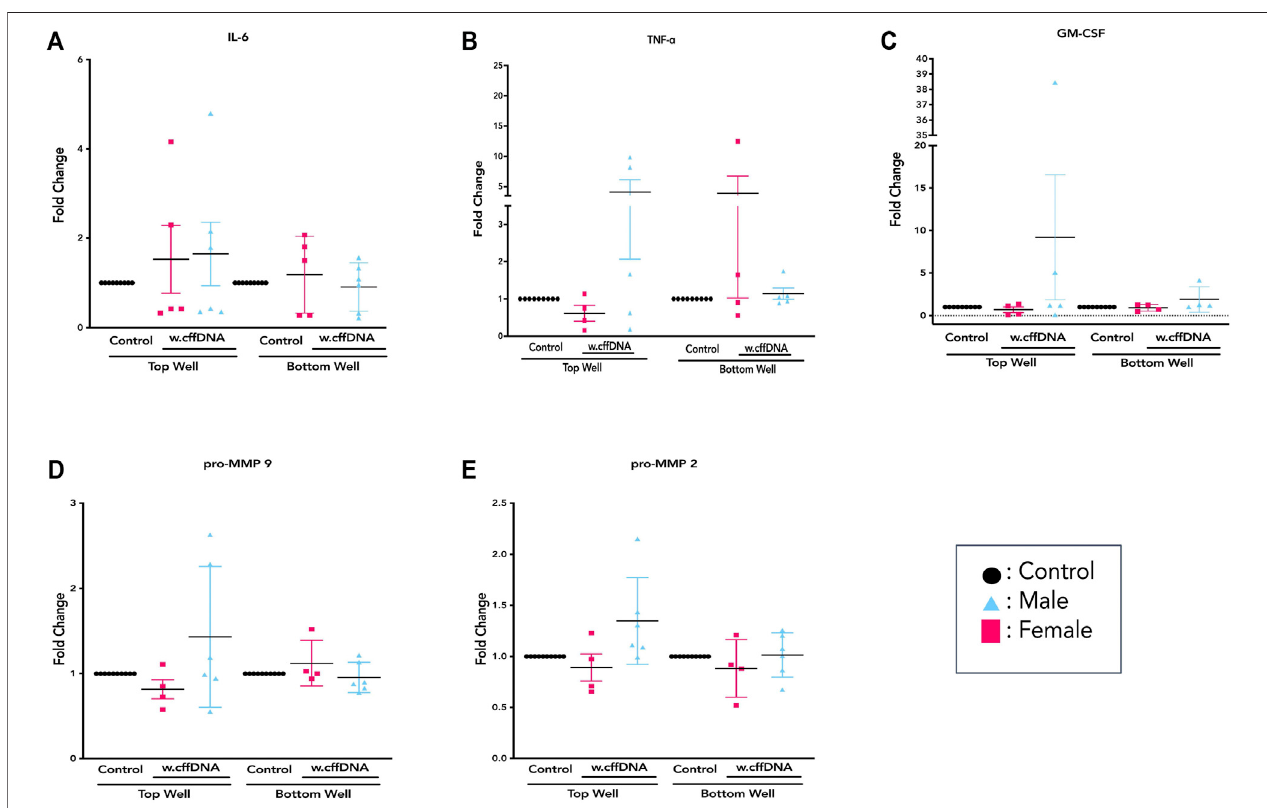
FIGURE6| Sex-speci fi cresponseofFMexplantstow.cffDNA. Thefoldchangesecretion,compared tonotreatmentcontrol, ofcytokines intotheapical (top)well or basal (bottom) well of the transwell fetal membrane explant after treatment with w.cffDNA at 100 ng/ml. (A) IL-6, (B) TNF-alpha, and (C) GM-CSF (D) pro-MMP9 (E) pro-MMP2. Black — untreated control. Blue- male fetus, and pink — female fetus. n = 7 – 10 patients. * p = < 0.05 ** p = < 0.001.